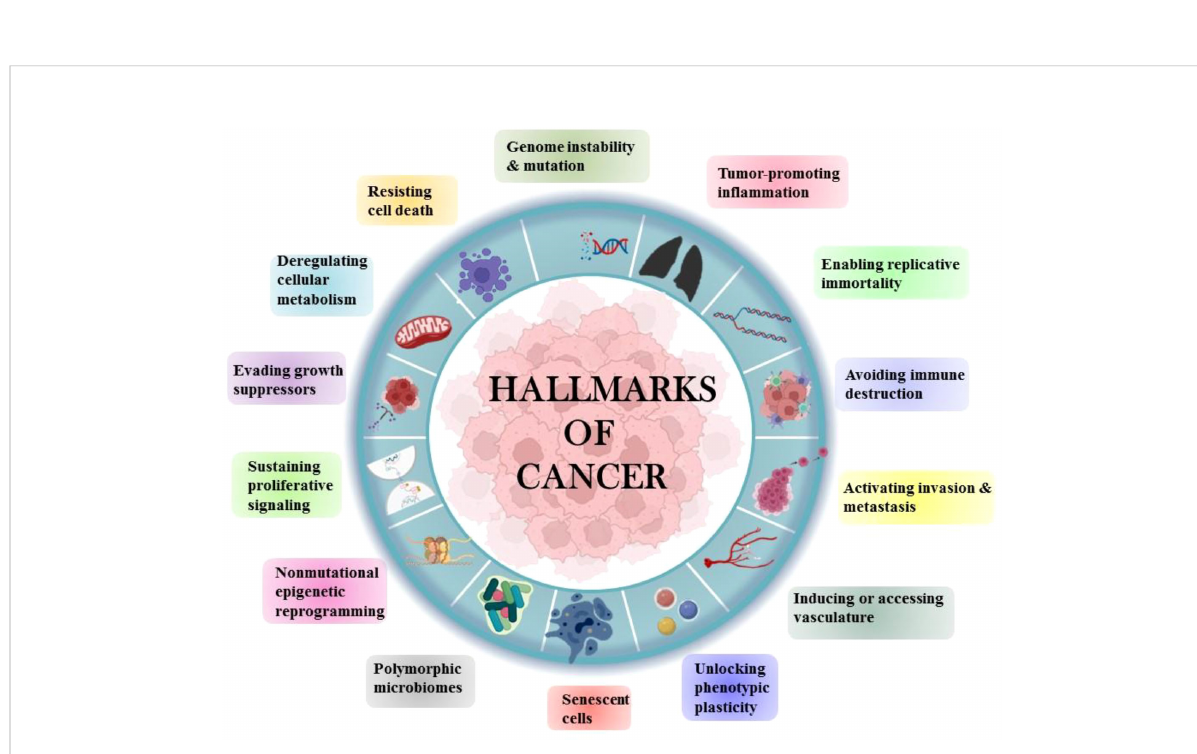
FIGURE 2 Hallmarks of Cancer.